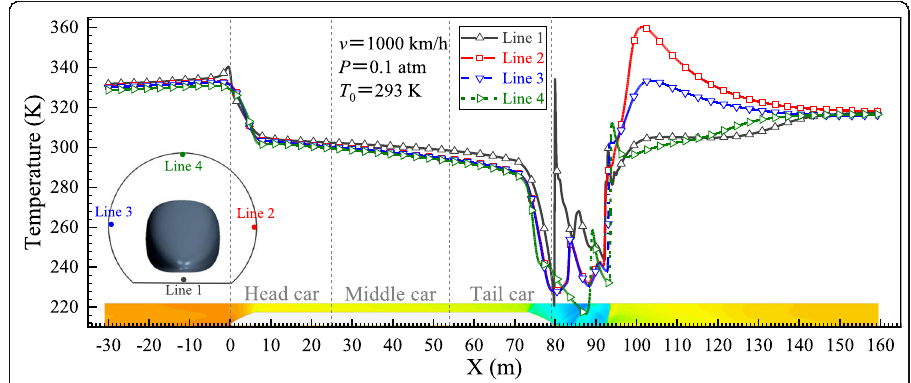
Fig. 10 Temperature distribution along the tube wall: x -coordinate ranges from − 30 m to 160 m